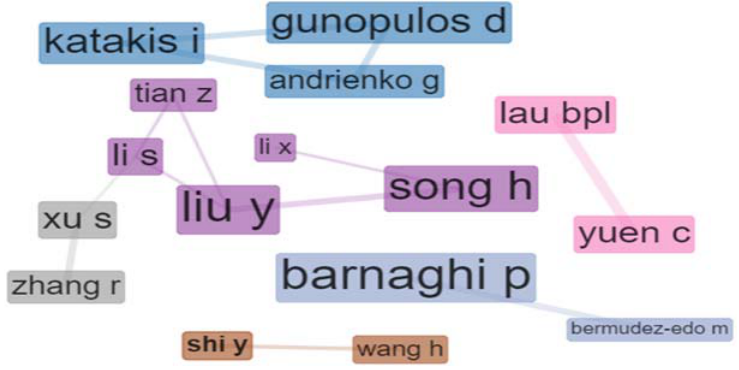
Figure 16. Collaboration network.